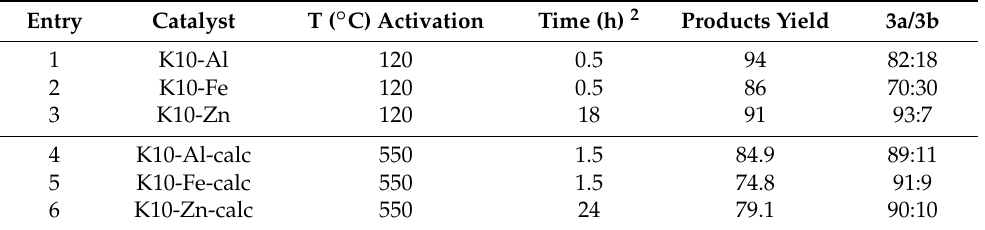
Table 1. Results of the reaction of glycidol ( 1 ) with methanol ( 2a ) at room temperature catalyzed by exchanged K10-Montmorillonites 1 .